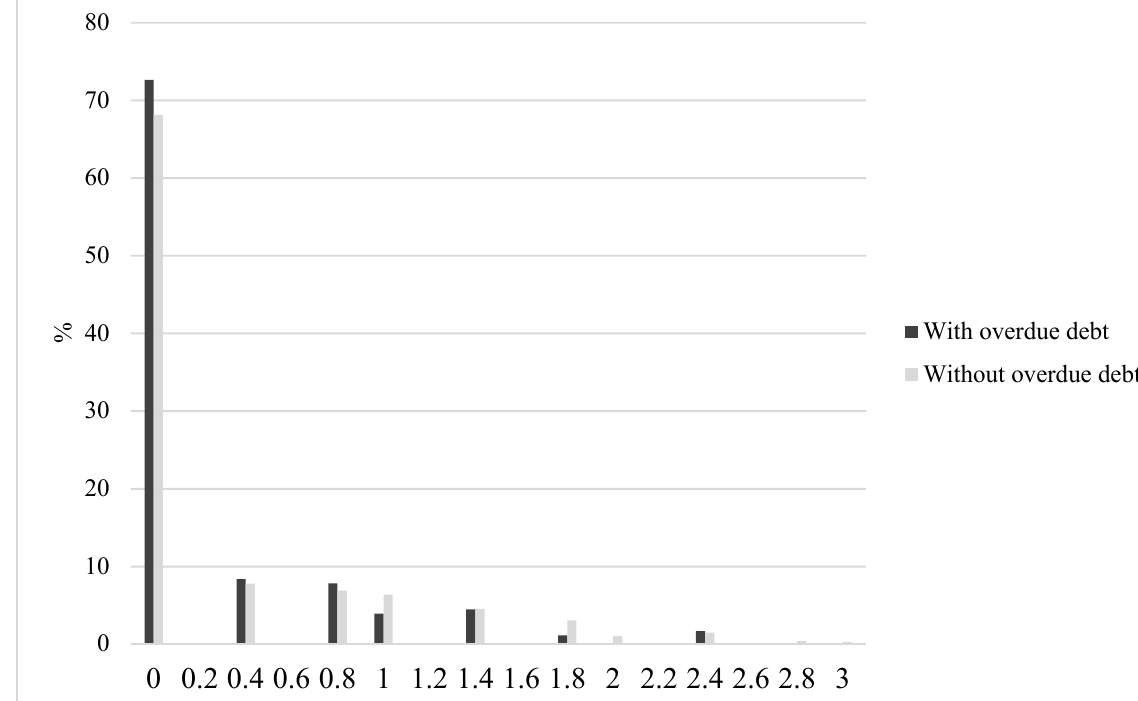
Figure 5. Distributions of the perceived social aversion to overdue debts in the subsamples with and without overdue debts. Source: Questionnaire-based survey, small settlements of BAZ County, Hungary, 2019.